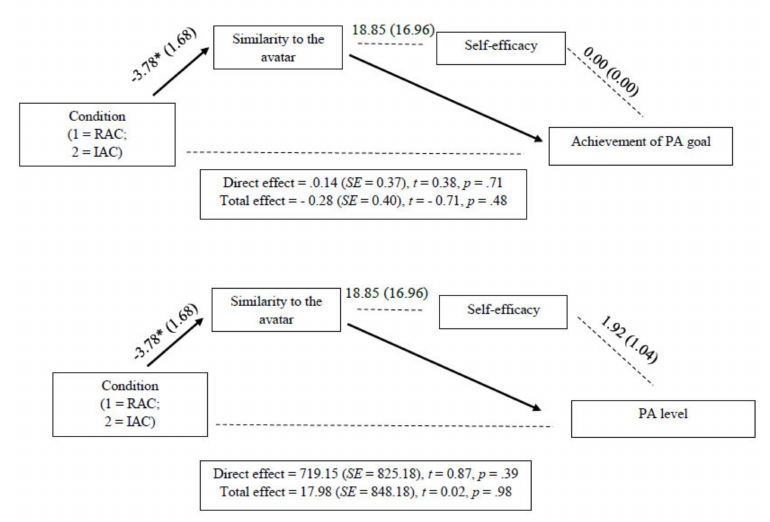
Figure 2. Serial multiple mediation analysis. Note. * p <